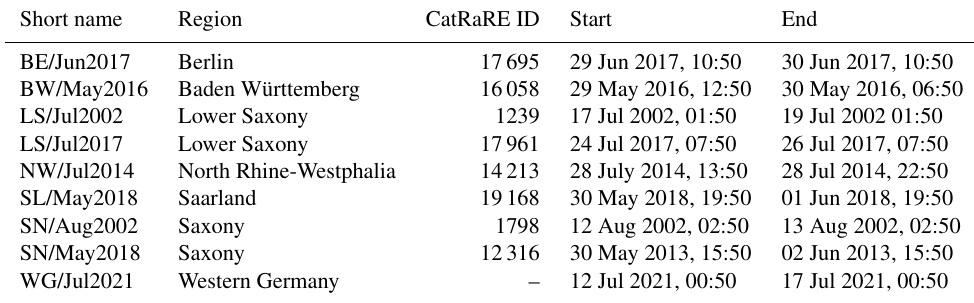
Table 1. Events used for case studies. The short name was constructed from an acronym that specifies the region in which the event occurred (mostly the federal state), the month, and the